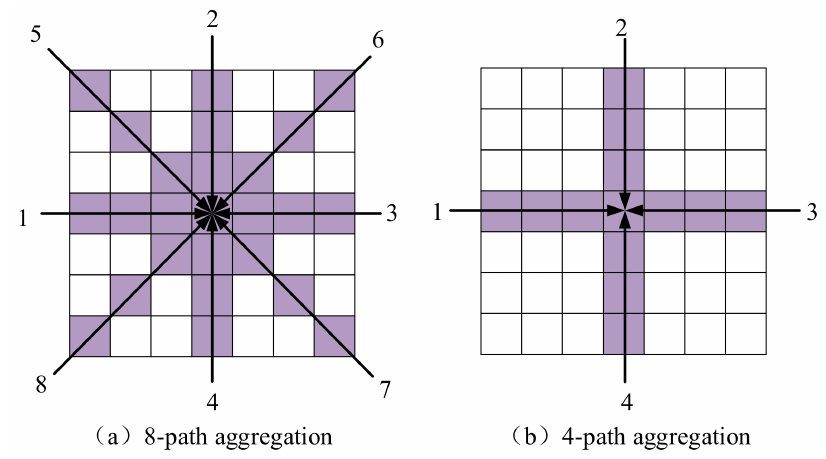
Figure 6. Schematic diagram of 8 and 4 path